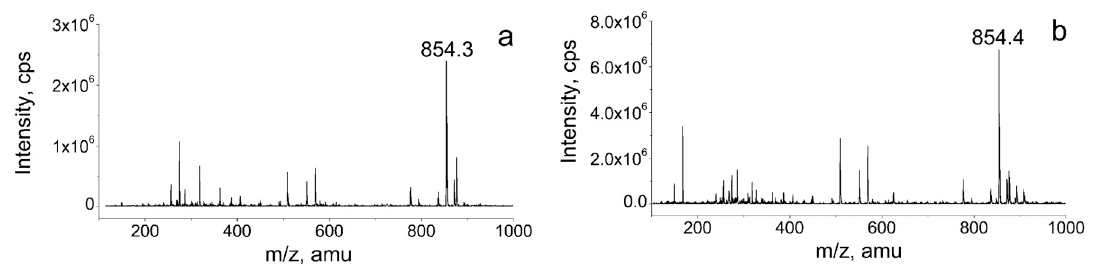
Figure 6. LC–MS spectra of the samples. ( a ) Raw PTX; and ( b ) PTX crystal powders.